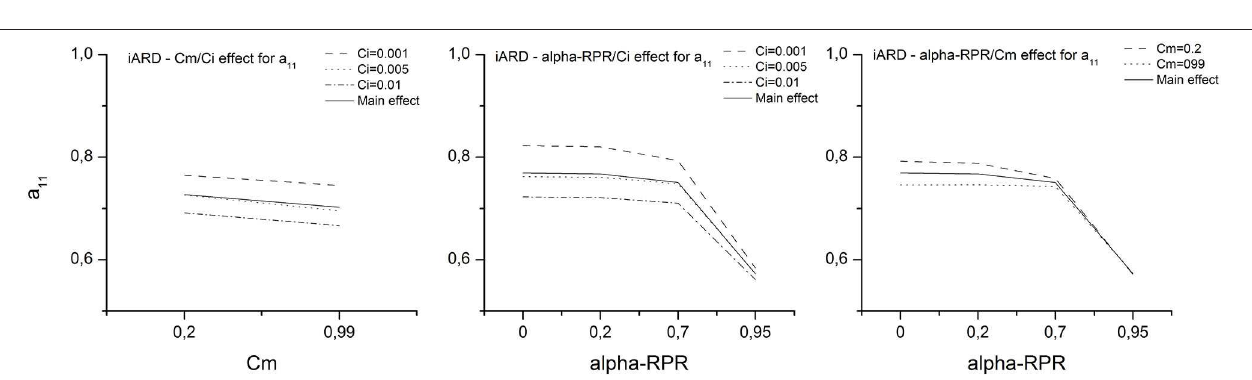
FIGURE 9 | Main effects and interaction of the iARD-RPR model parameters. Cm = 44.46%, alpha-RPR = 29.07%, and error = 13.17%; and P(%) over a 33 , Ci = 52.88%, Cm = 39.85%, alpha-RPR =